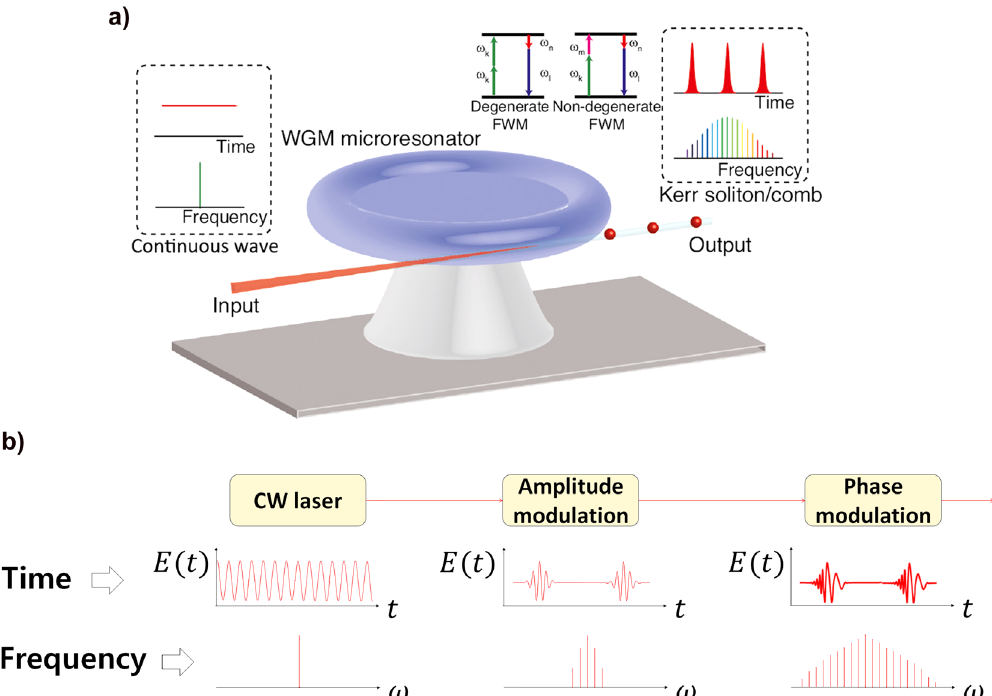
Figure 18: Optical frequency comb generation. (a) A typical 3D sketch of a toroidal cavity, one of the WGM microresonators, and the optical frequency comb generator. The input CW laser